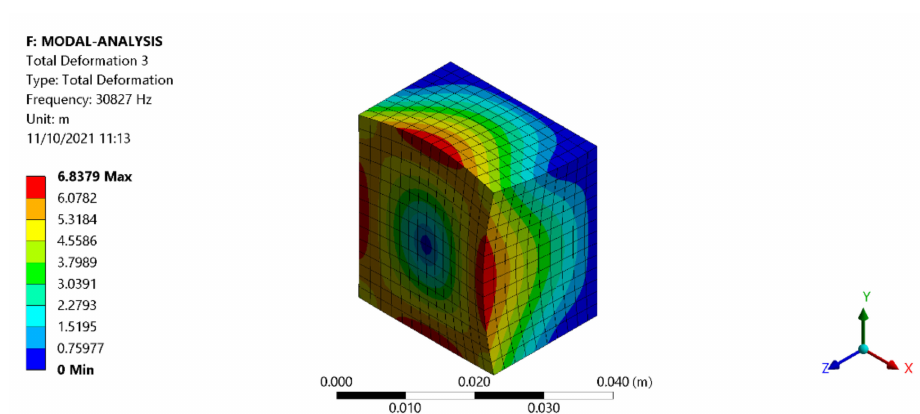
Figure 14. The third modal shape of the pair.